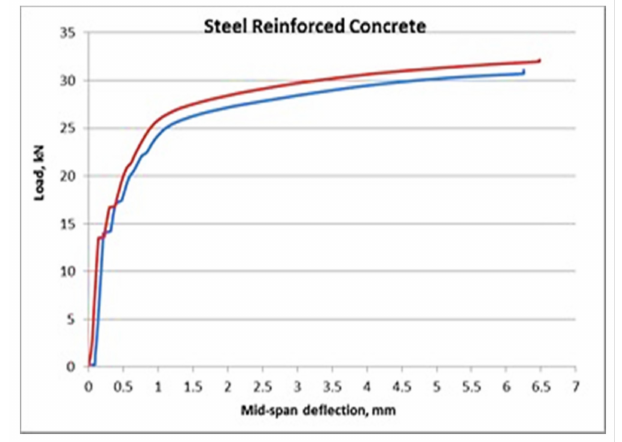
Figure 20. Mid-span load-deflection of the SRC beam samples.